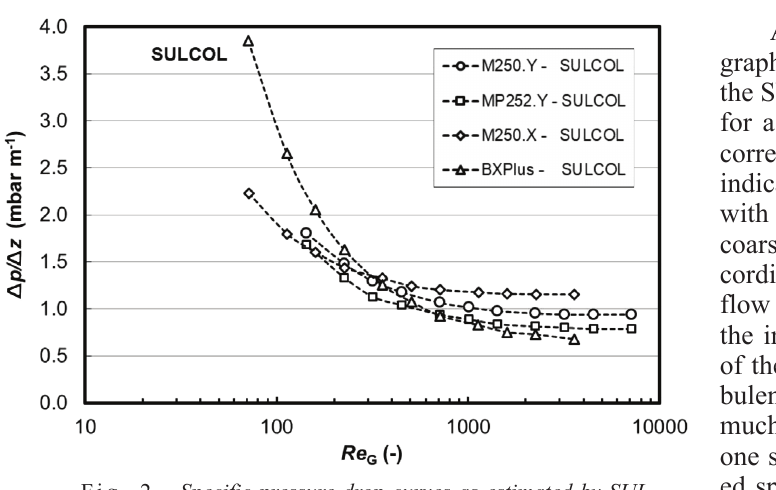
Fig. 2 – Specific pressure drop curves as estimated by SUL- COL using drag coefficient values shown in Fig.